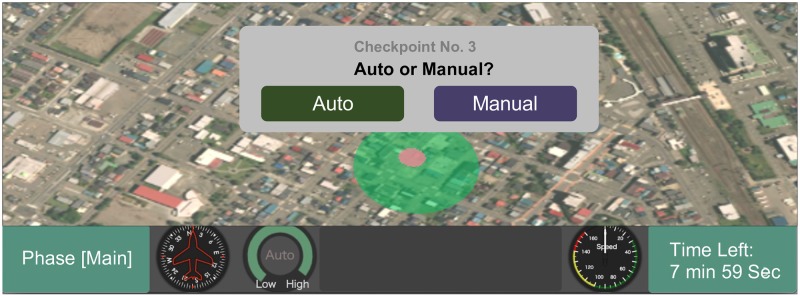
Popup message asking the participants for choice.Geospatial Information Authority of Japan (https://maps.gsi.go.jp) CC BY 4.0 The image is similar but not identical to the original one used in the experiment due to a copyright reason.